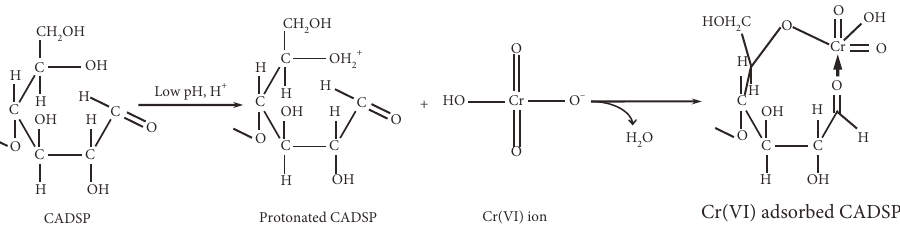
Scheme 2: Mechanism of Cr(VI) biosorption on CADSP.